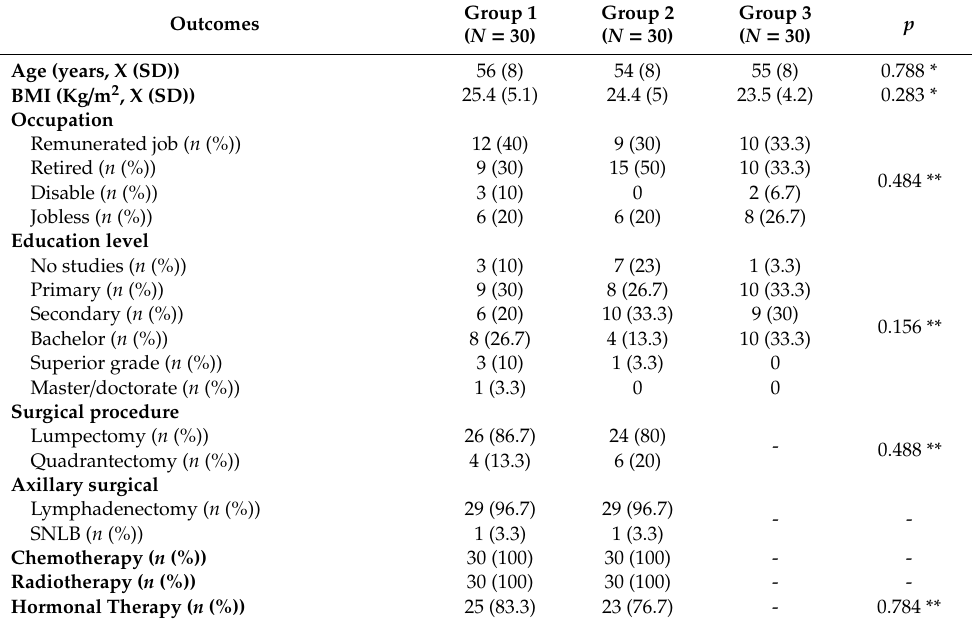
Table 1. Demographic, anthropometric, therapeutic, and clinical